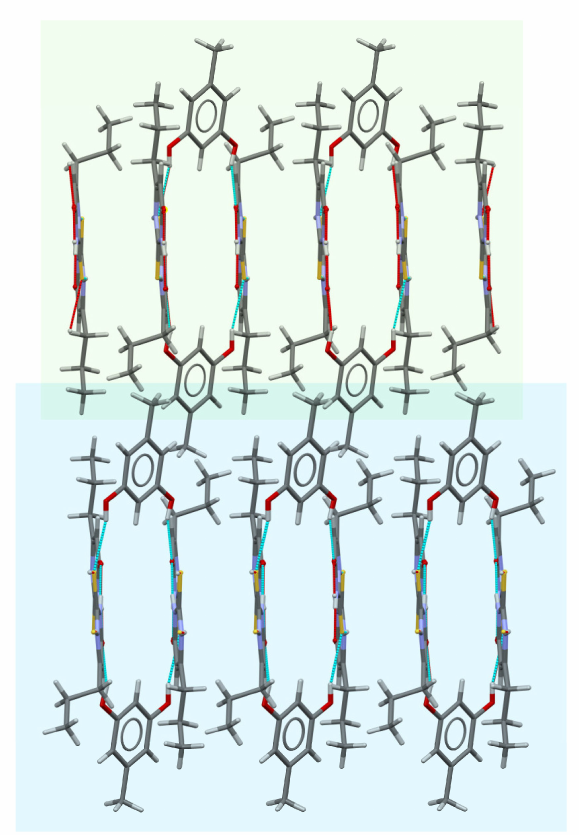
Figure 8. Packing arrangement of 2D layers in the crystal structure of